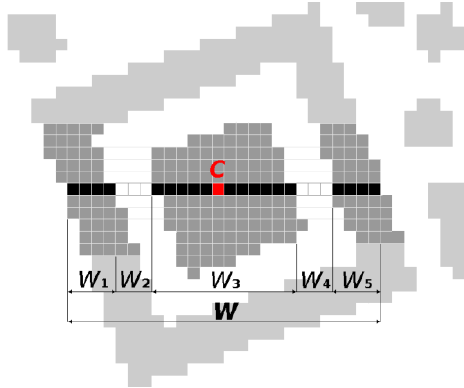
Figure 5. A Finder Pattern candidate matching 1:1:3:1:1 horizontally.